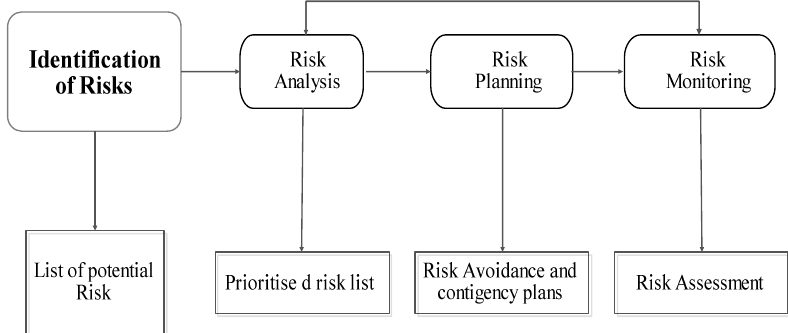
Fig 1. The risk management